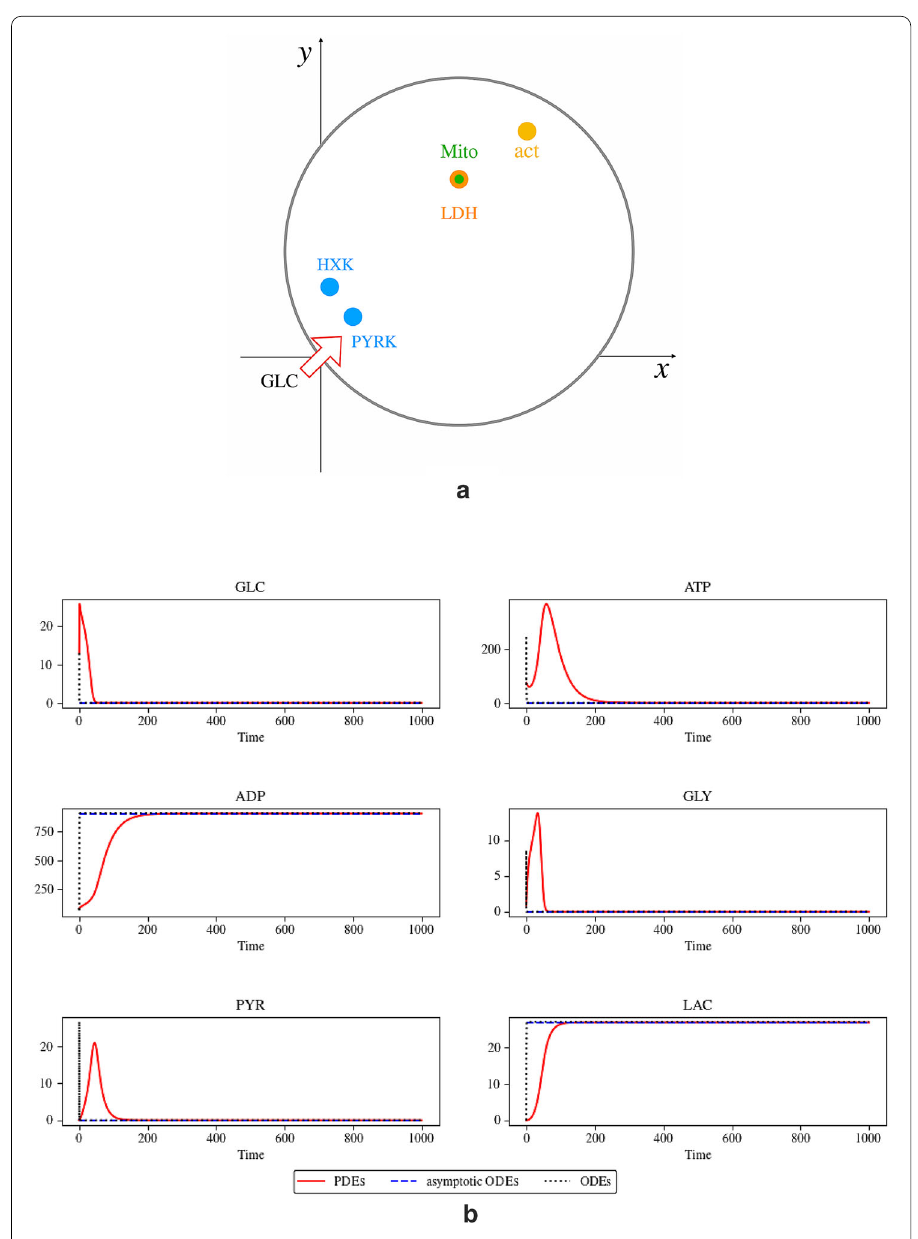
Fig. 5 a The locations of the chemical reactions Eqs. (1)–(5) and the influx of GLC are shown in the circular domain in order to prove the convergence of the PDEs solutions to the ODEs. Note, the chemical reactions LDH Eq. (3) and Mito Eq. (4) have been placed in the same location. b The solutions of the PDEs obtained using CutFEM and integrated over the domain (red line) are plot in comparison with the asymptotic solutions of the ODEs for each concentration (blue line) and with the ODEs solved using scipy . The convergence of the PDEs to the ODEs solutions is reached for t >